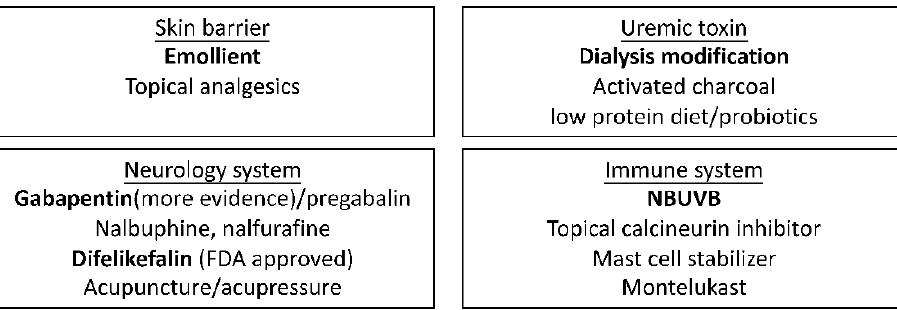
Figure 2. Treatment options for uremic pruritus classified by possible targeted etiologies. The bold ones have greater evidence in current literature.